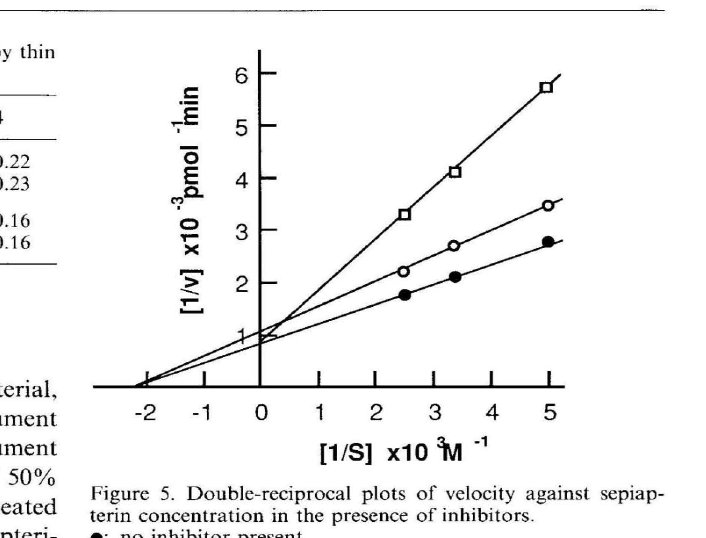
Figure 5. Double-reciprocal plots of velocity against sepiap terin concentration in the presence of inhibitors. .: no inhibitor present. 0: 3 x 10- 4 M p-chloromercuribenzoate